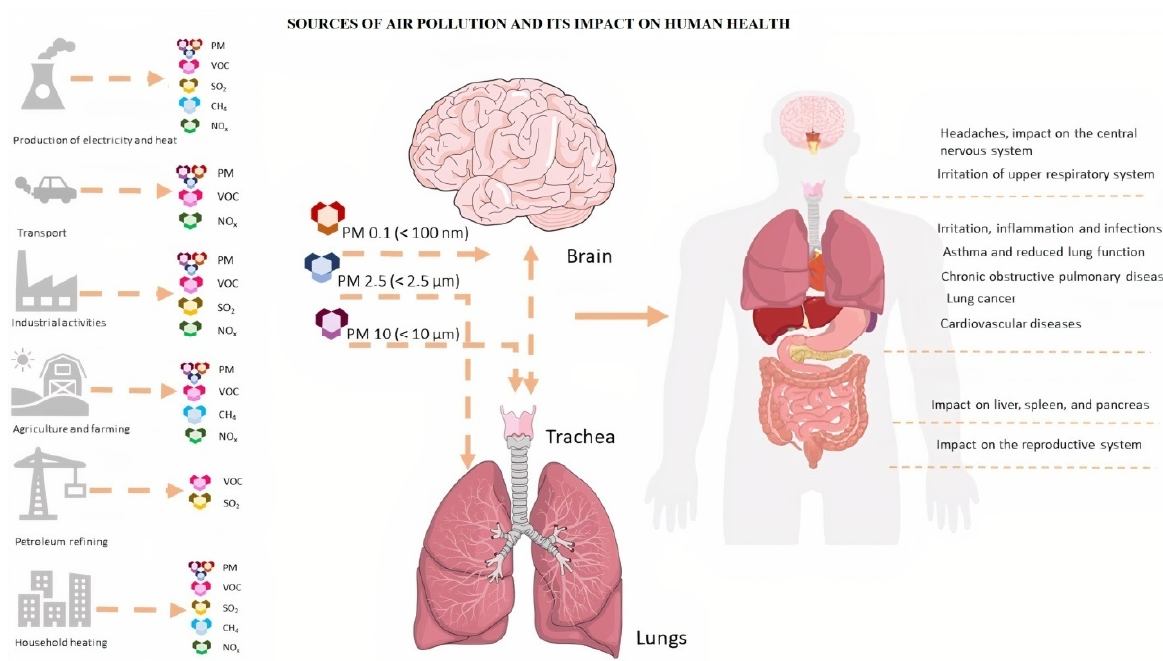
Figure 1. Major sources of air pollution and its negative impact on human health. The figure prepared by Marta Jaskulak on the basis of literature